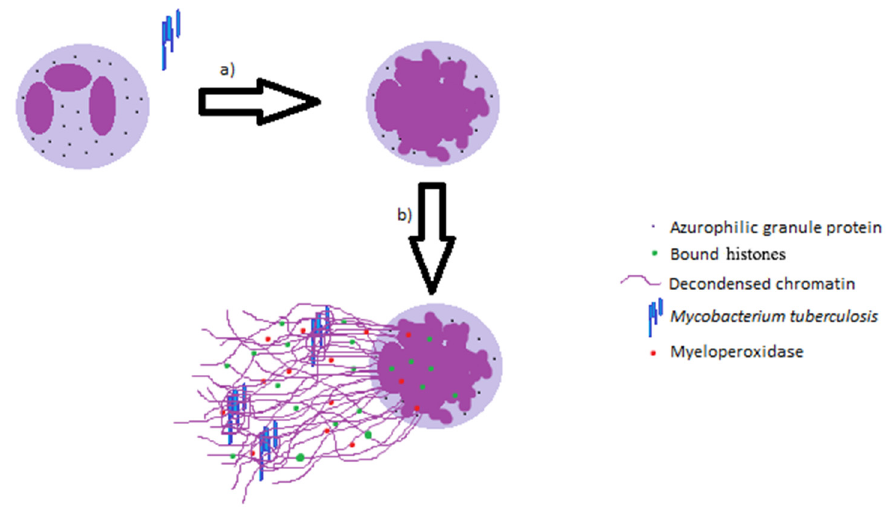
Figure 1. Formation of neutrophil extracellular traps (NETs) during the innate immune response to M. tb . ( a ) Structural alterations of the nuclear shape with chromatin decondensation; ( b ) release of the intracellular structures and net exposure.